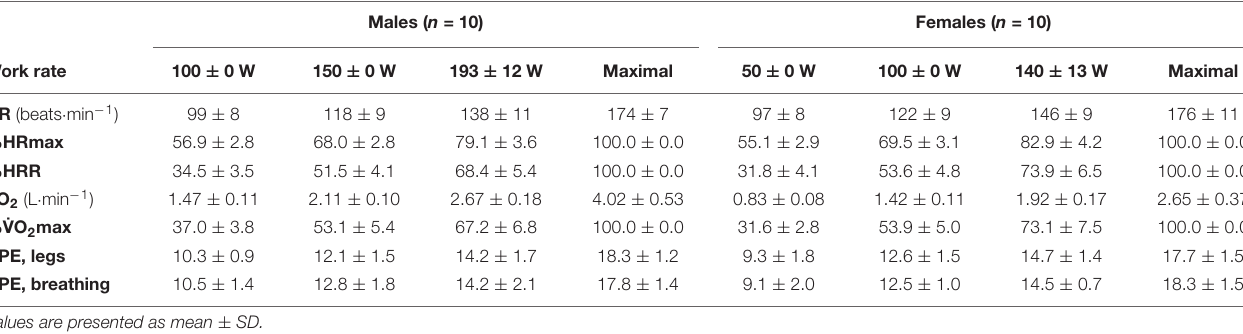
TABLE 3 | Heart rate (HR), oxygen uptake (˙VO 2 ) and rated perceived exertion (RPE) of cycle ergometer work rates in the laboratory.